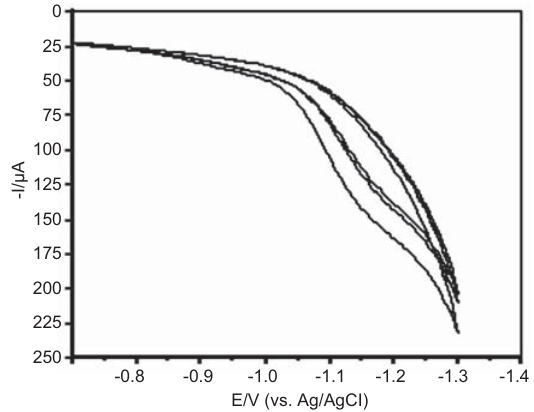
Figure 2 The repetitive cyclic voltammograms of 0.5 m m ABA solutions in phosphate buffer, pH 3.0 (with 0.02 m NaCl) for pencil- lead BiFE. Scan rate, 200